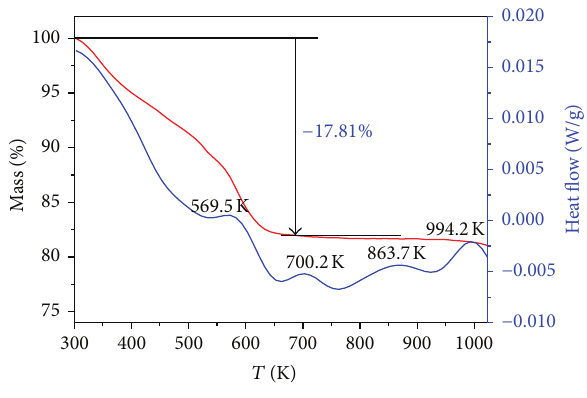
Figure 1: TG-DTA curves of resultant 2 .